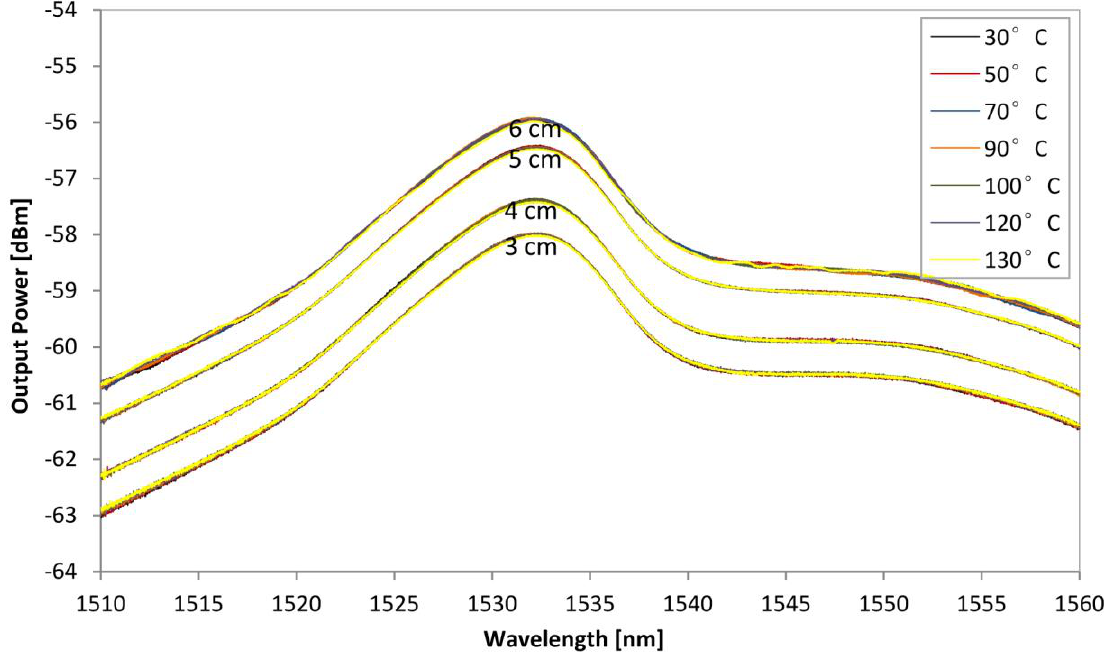
Figure 9. The ASE spectrum level of the BSEDF at different temperature for different spooling diameter.